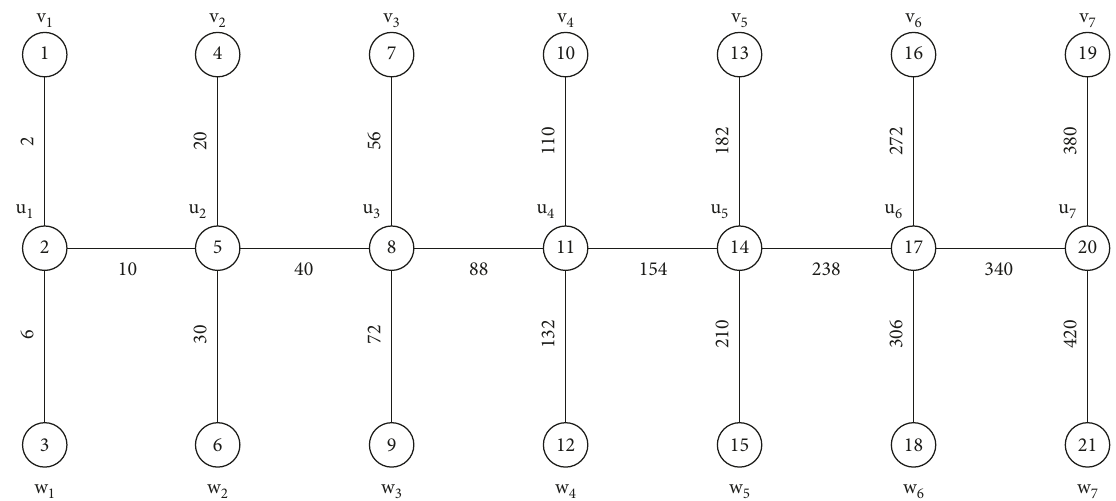
Figure 4: Representation of ( DC